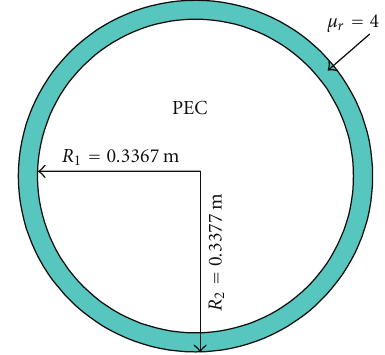
Figure 3: Conducting sphere coated by magnetic material.